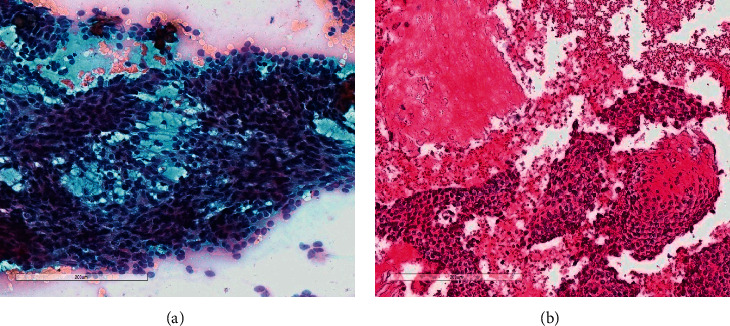
(a) Conventional smear showing basaloid cells in sheets, with focal squamous appearance (Papanicoloau stain, 100x) and (b) cell block preparations confirming the presence of basaloid cells with squamous differentiation, in addition to ghost cells (H&E, 100x).